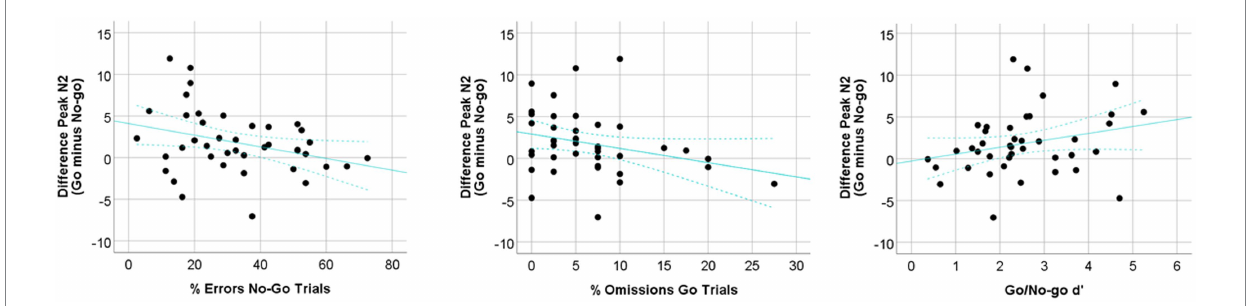
FIGURE 3 Correlation plots for the Go/No-go behavioral measures and the difference in peak amplitude (Go minus No-go condition) of the N2 ERP component.